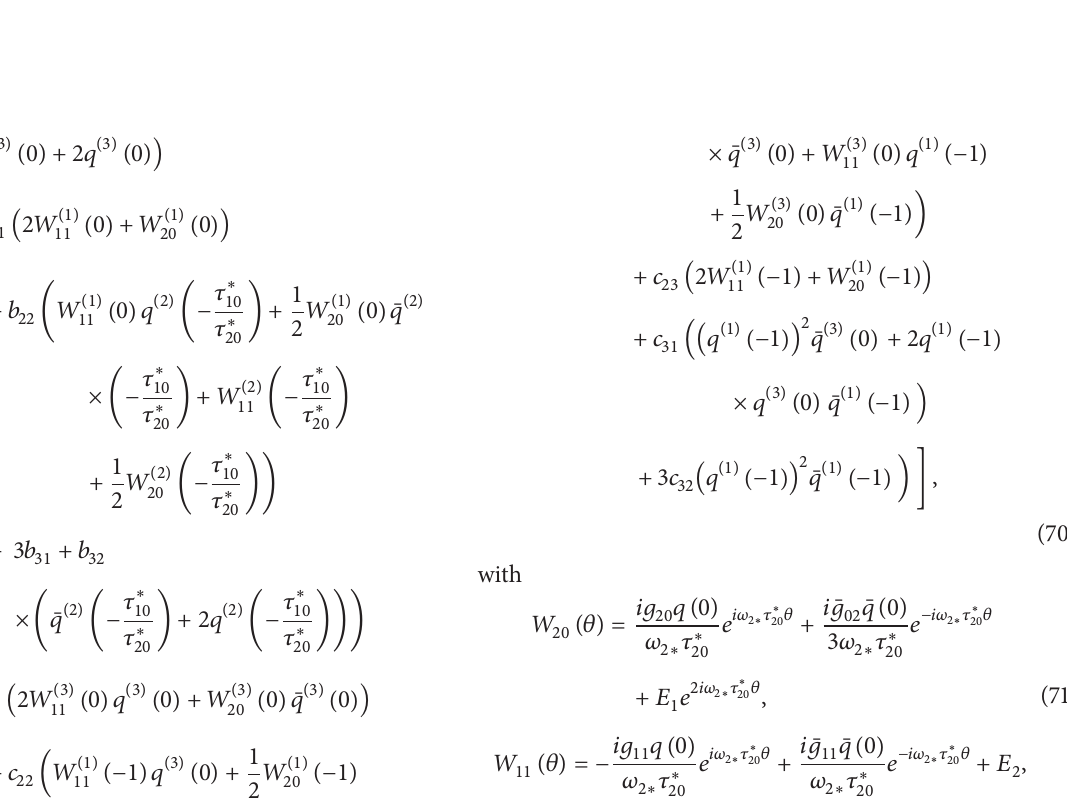
Figure 6: 𝐸 ∗ is unstable when 𝜏 = 0.45 > 0.3652 = 𝜏 0